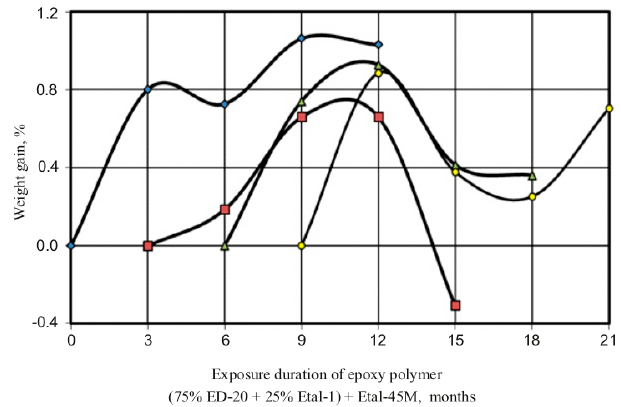
Figure 7. Change in the mass of epoxy polymer samples (75% ED-20 + 25% Etal-1) + Etal-45M relative to the common time axis for water absorption.